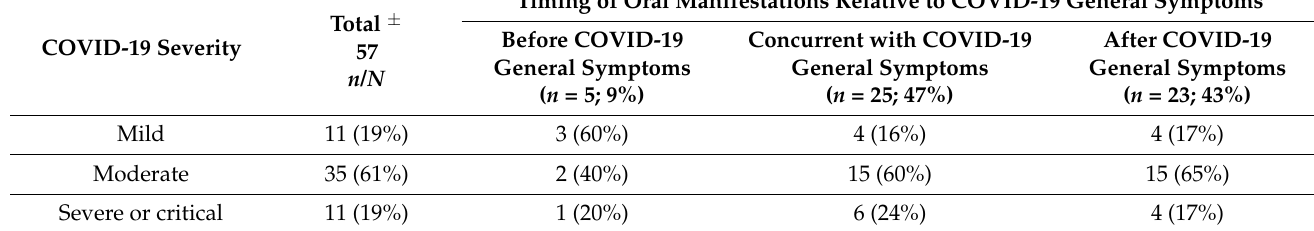
Table 4. Temporal relationship of oral manifestations of and general symptoms of COVID-19 in 53 of the 57 participants with oral manifestations of